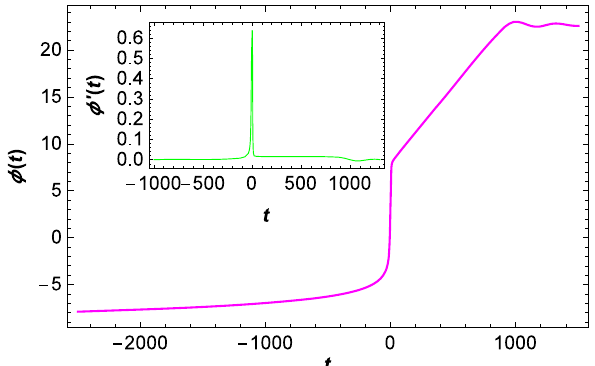
Fig. 1 The evolution of φ and ˙ φ , while we set f 1 = 5, f 2 = − 0 . 23, f 3 = − 13 f 2 , q 1 = 1, q 2 = 0 . 2, q 3 = 0 . 2, q 4 = 2, λ = 4 × 10 − 4 , φ = 7, φ = 22 . 7 and φ = 5 . 0 1 2